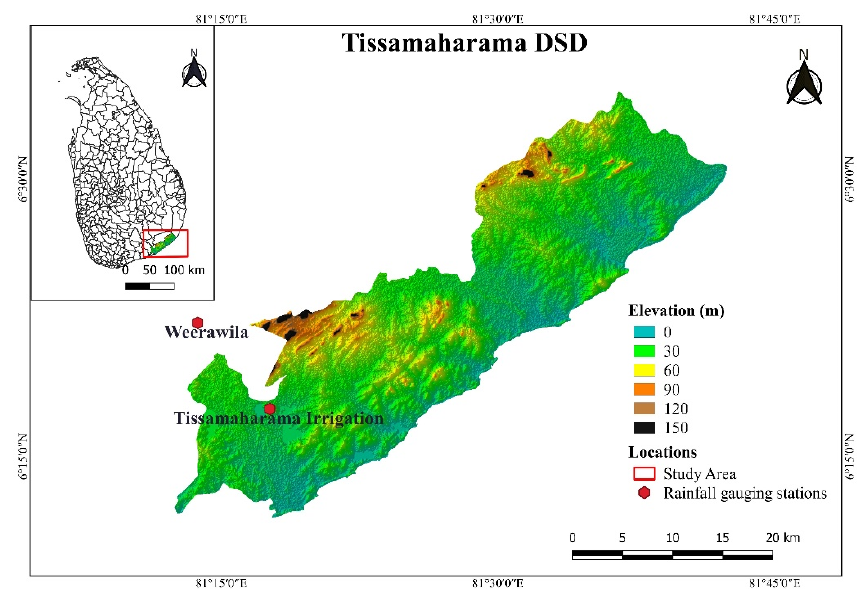
Figure 1. Location of the study area, Tissamaharama DSD in Sri Lanka.